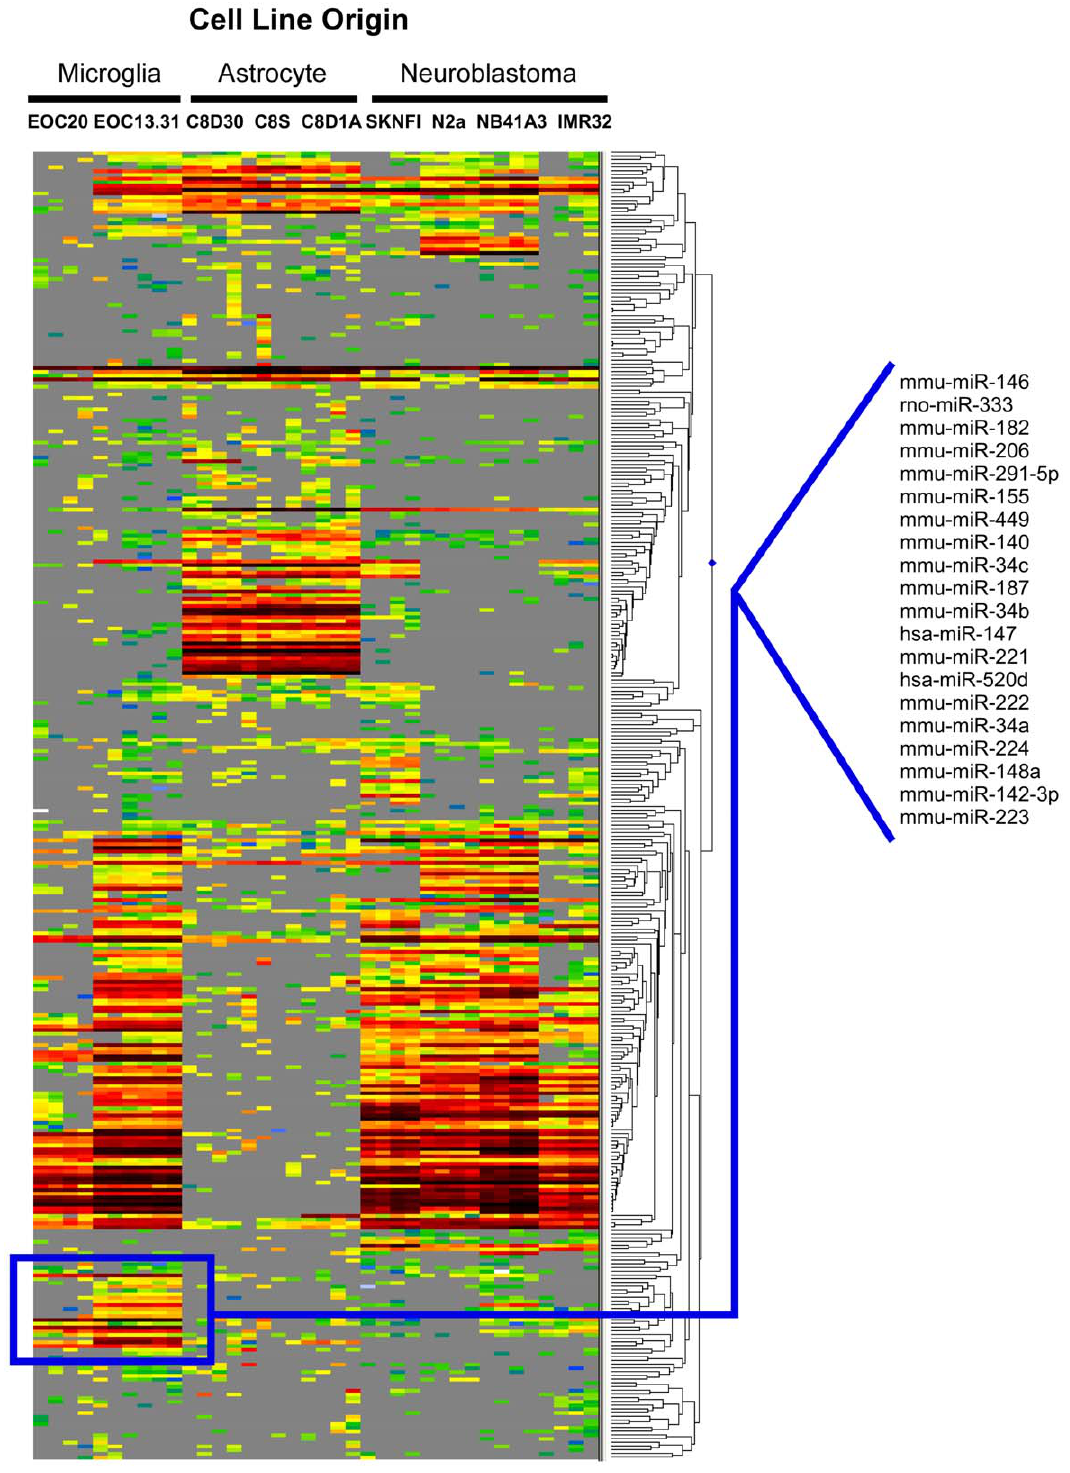
Figure 1. Hierarchical cluster plot generated from miRNA expression profiling of a repertoire of a variety of CNS cell lineages (neuronal, microglia, astrocytes). A microglia specific cluster of miRNAs is indicated. Red indicates high levels of miRNA expression, green low levels and gray indicates expression that was undetected by the microarray used. doi:10.1371/journal.pone.0030832.g001 line was chosen rather than BV-2 due to high levels of transfected longer, up to 36 hours post infection, despite the fact that the anti-miR (complementary to miRNA) and pre-miR (precursor transfection rates for both cells were similar (data not shown). This miRNA or miRNA mimics) being detectable in the cells for much was likely due to differences in the proliferation rates exhibited by